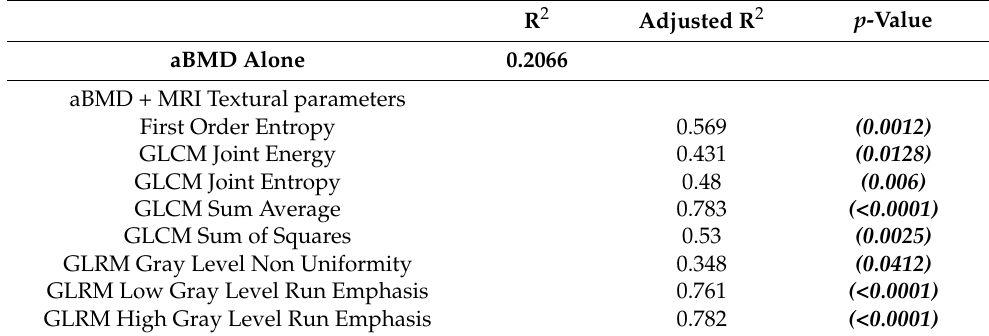
Table 5. Multiple regression analysis: combinations of aBMD and MRI textural parameters used to explain the femur failure load (aBMD: areal bone mineral density; GLCM: grey level co-occurrence matrix; GLRM: grey level run-length matrix). In bold and italic, p -value under 0.05.